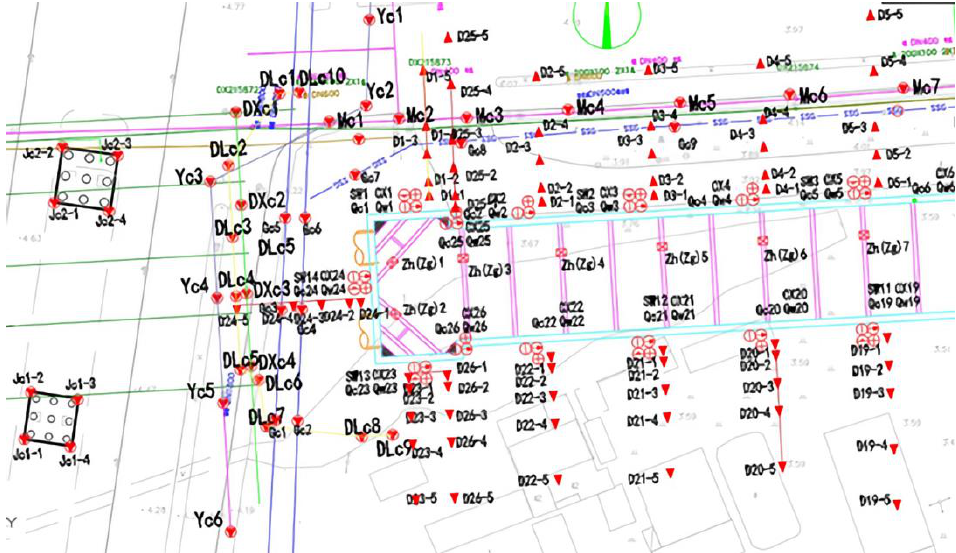
Figure 3. The layout of monitoring sections of ground settlements.